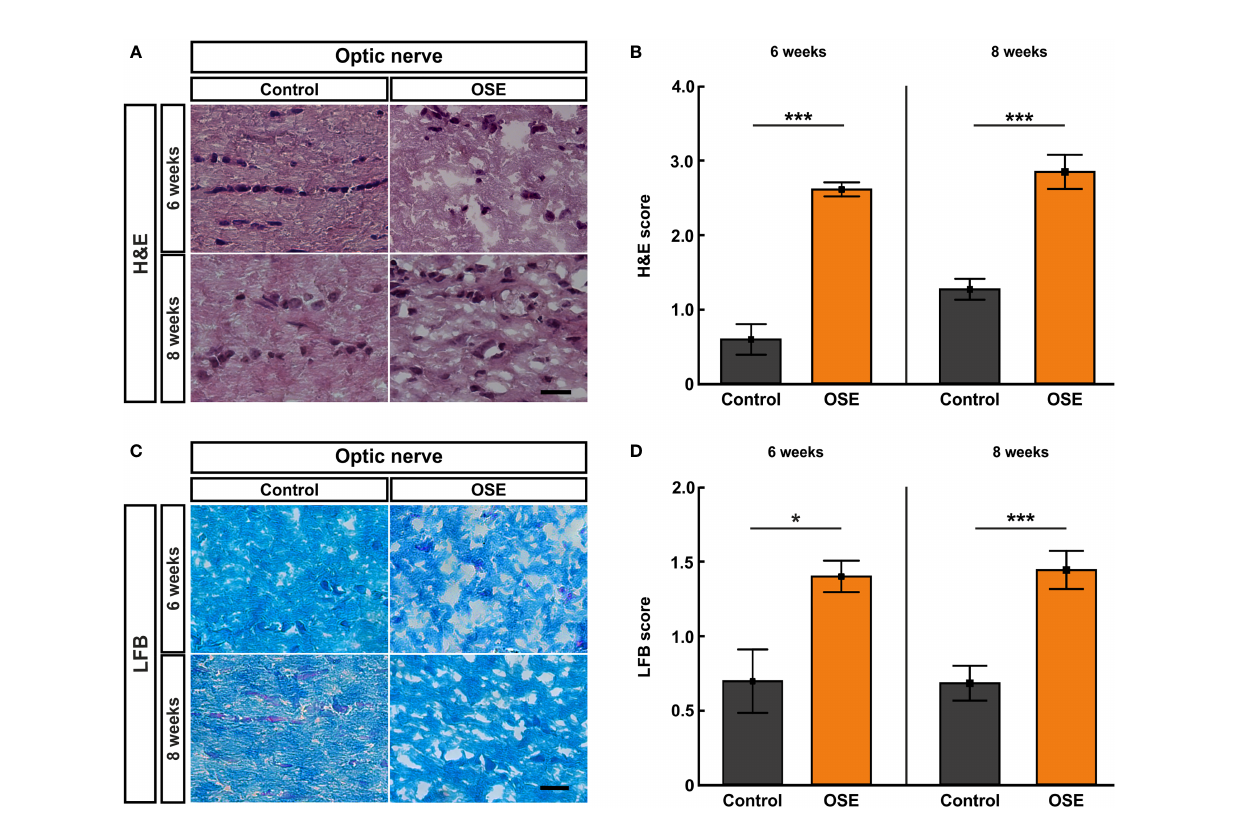
FIGURE 3 | Structural damage and increased demyelination of the optic nerve. (A) H&E stainings were performed after six and eight weeks to evaluate the morphology of the optic nerve. (B) The optic nerves of OSE mice showed a signi fi cantly elevated H&E score compared to the control group at both ages. (C) LFB- stained myelin sheaths of the control and OSE group are displayed. (D) Demyelination was increased in the OSE group as indicated in a higher LFB score at six as well at eight weeks of age. Data are shown as mean ± SEM. *p < 0.05, ***p < 0.001. Scale bars: 20 m